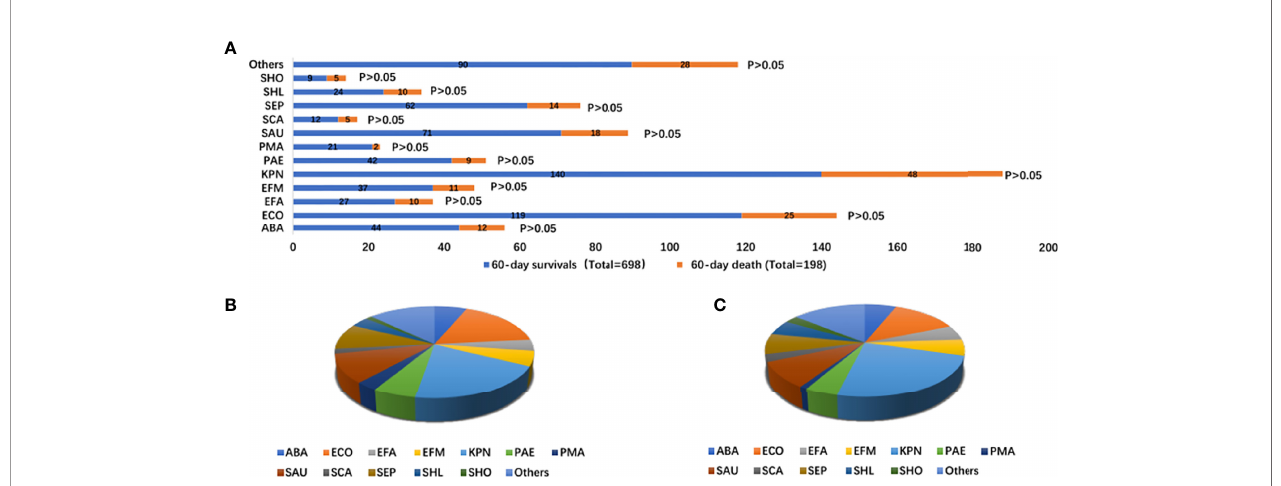
FIGURE 3 | Distribution of infectious microorganisms of bloodstream infection according to 60-day survivals and 60-day death strati fi cations (A) ; proportion of types of infectious microorganisms of bloodstream infection with 60-day survivals (total = 698) (B) ; proportion of infectious microorganisms of bloodstream infection with 60-day death (total = 197) (C) . ABA, Acinetobacter baumannii; ECO, Escherichia Coli; EFA, Enterococcus faecalis; EFM, Enterococcus faecium; KPN, Klebsiella pneumoniae; PAE, seudomonas aeruginosa; PMA, Stenotrophomonas maltophilia; SAU, Staphylococcus aureus; SCA, Paratyphoid C; SEP, Staphylococcus epidermidis; SHL, Staphylococcus haemolyticus; SHO, Staphylococcus hominis.